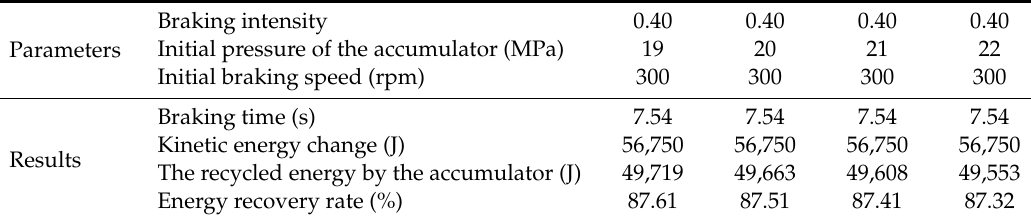
Table 4. The simulation results in operating mode with di ff erent initial pressure of the accumulator.